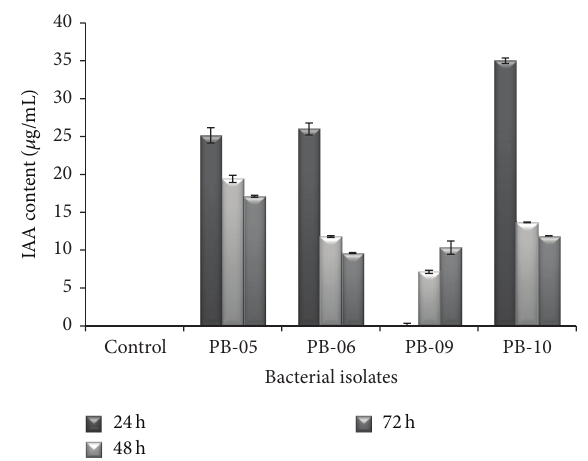
Figure 1: Effect of time on phosphate solubilization by bacterial